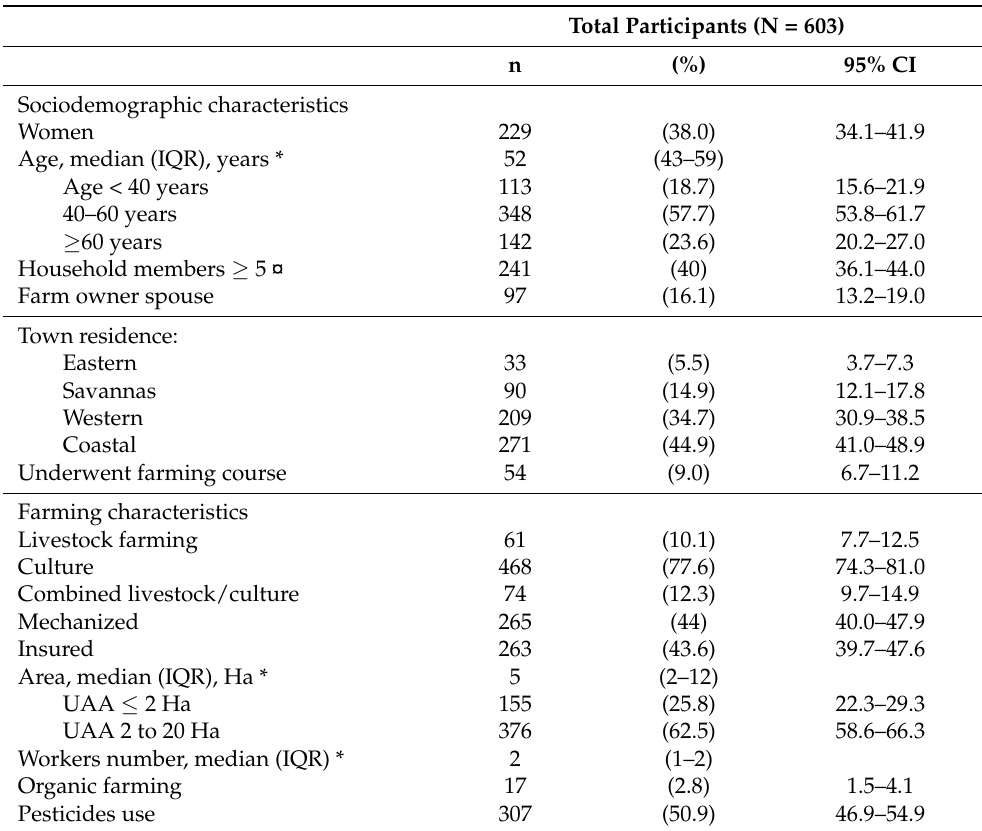
Table 1. Sociodemographic and farming characteristics of the 603 participants in Novembre Vert